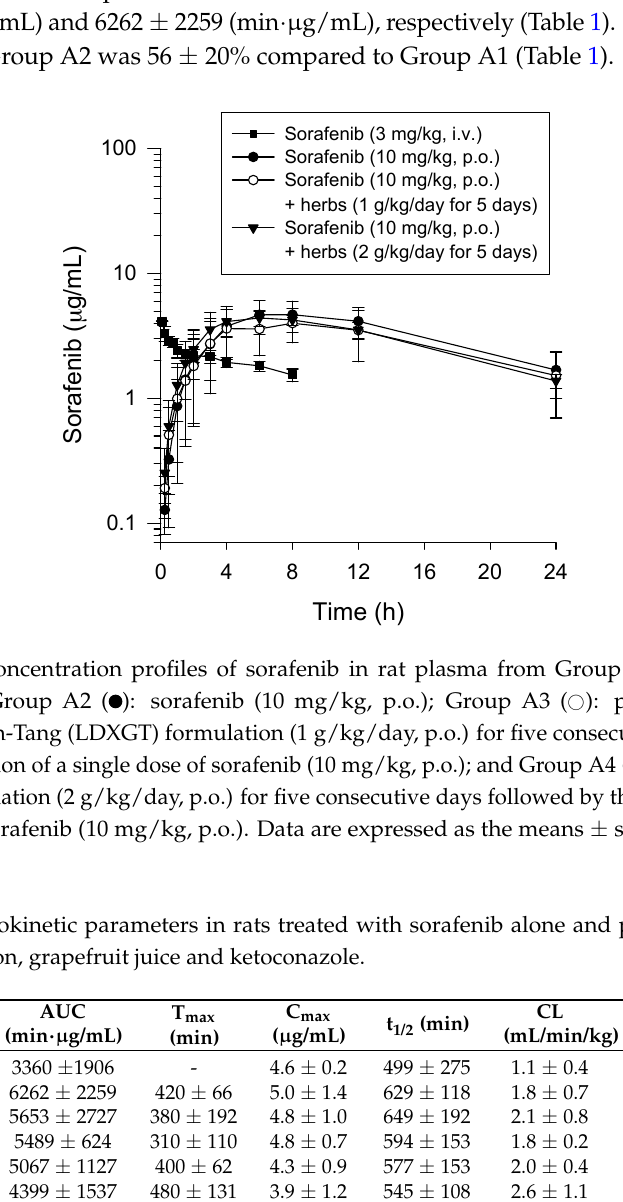
): pretreated with the (cid:35)